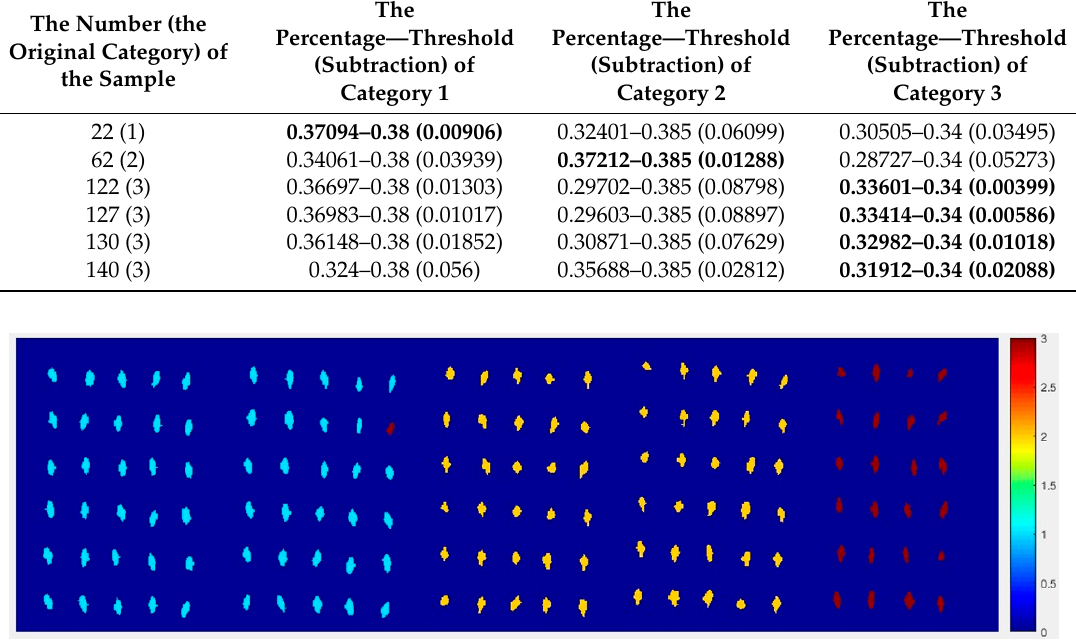
Figure 15. The final visualization images of Jindan10 with the SPA and PLS-DA model with method M2P. method